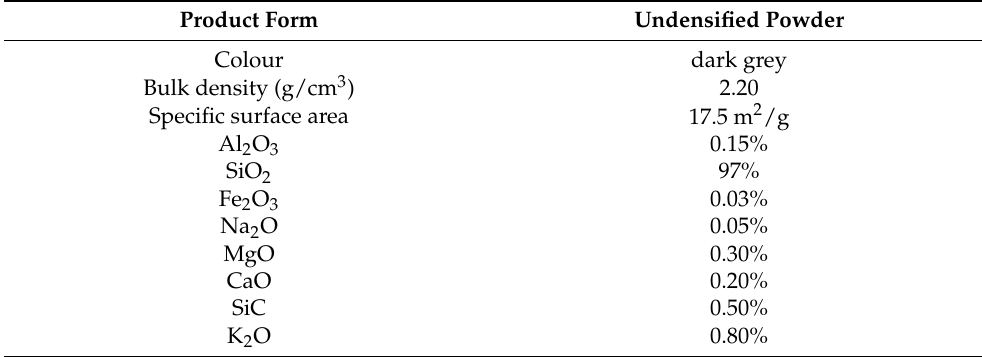
Table 2. Silica fume characteristics.